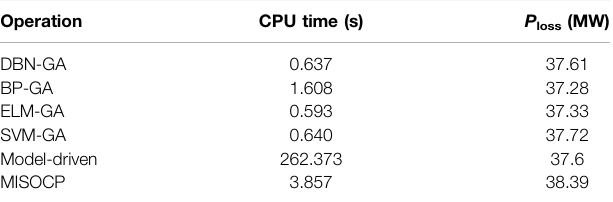
TABLE 7 | Comparison of data-driven genetic algorithm (GA), model-driven GA, and MISOCP. Operation CPU time (s)